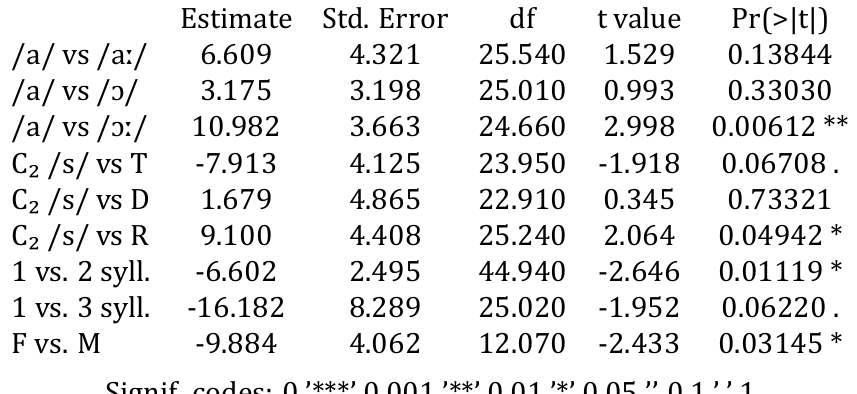
Table A.8: Post-aspiration duration of C₁ T as a dependent variable